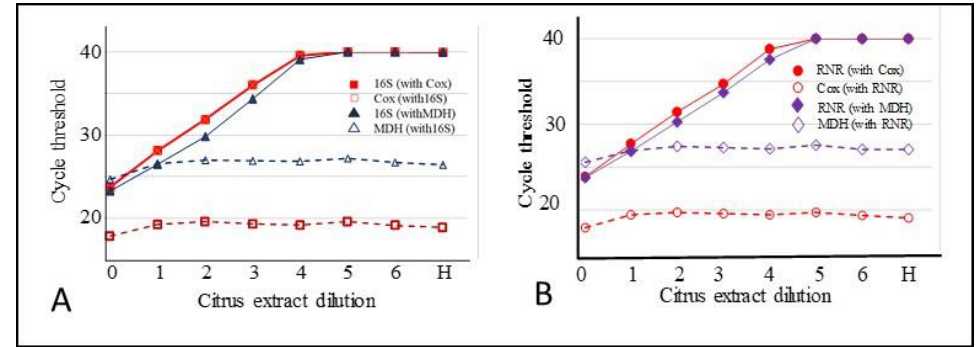
Figure 4. ( A ) Comparison of qPCR data in duplex assays amplifying 16S rDNA of CLas along with two separate reference genes, COX or MDH. ( B ). Comparison of qPCR amplification of CLas RNR gene along with COX or MDH in duplex reactions. Healthy citrus extracts were used to dilute CLas positive extracts. The CLas positive citrus extraction was diluted using CLas negative citrus extraction (H) as a diluent resulting in a near-constant Ct value of COX (about 18) and for MDH (about 26) in all dilutions. Ct values for the reference genes were approximately constant across dilutions. Ct value of 40 indicates a lack of